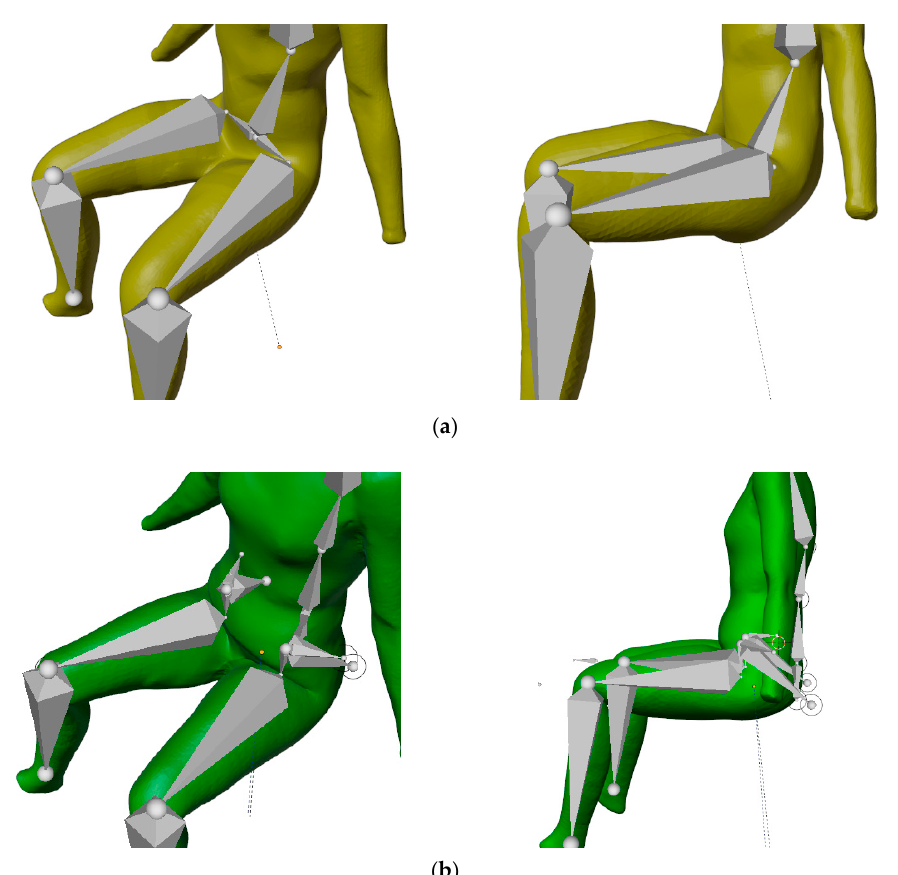
Figure 6. Armature structure of kinematic 3D body model: ( a ) simple armature in pelvic region, ( b ) improved armature with helper bones in pelvic region.